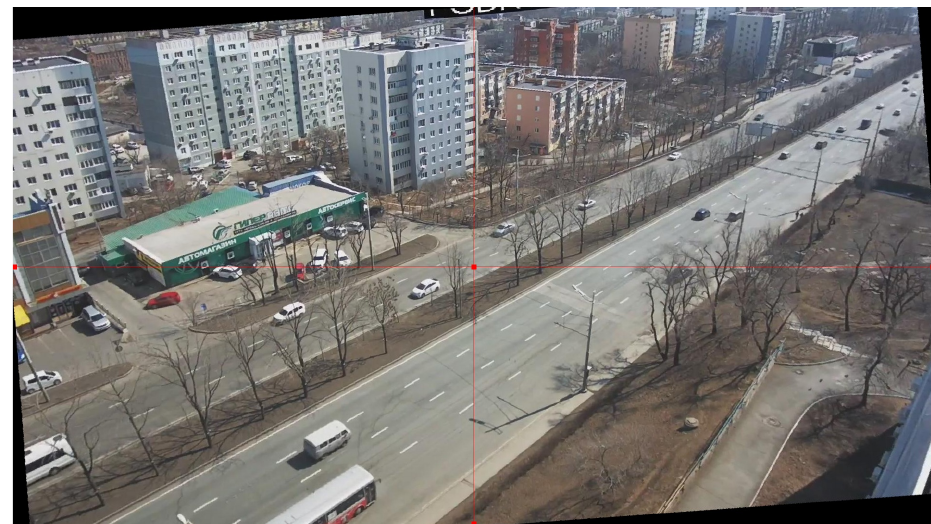
Figure 5. The image ˆ Φ rotated by 4.1 ◦ around the optical axis of the camera.